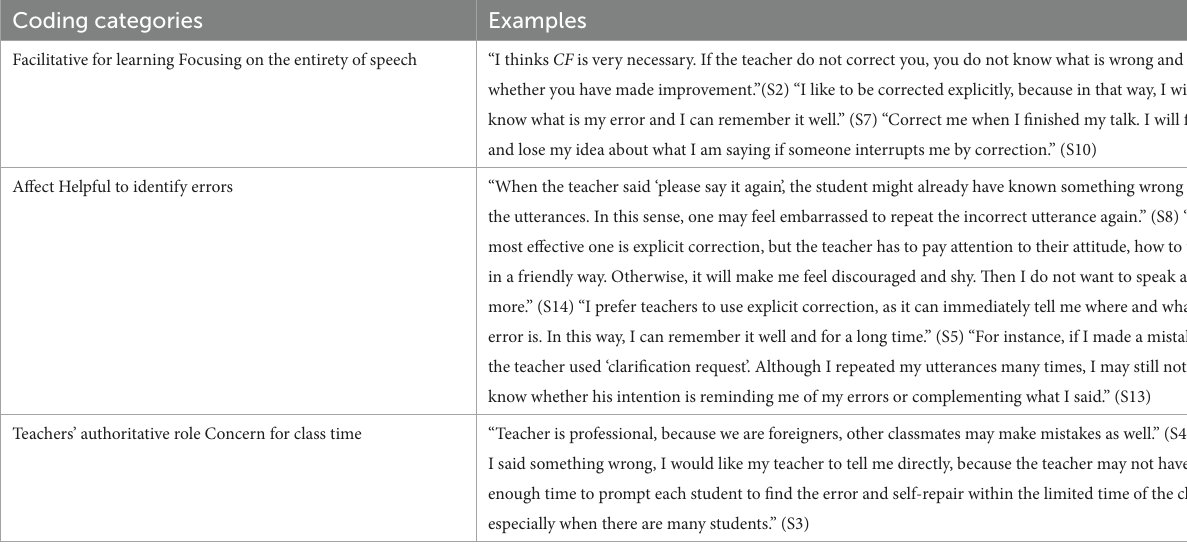
TABLE 8 Comments from the students for their CF